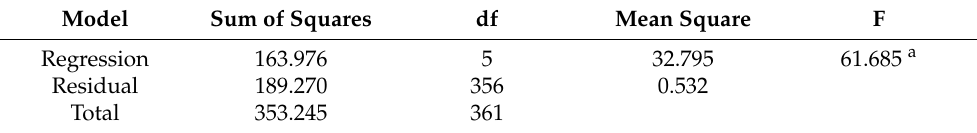
Table 5. Regression 1: ANOVA b